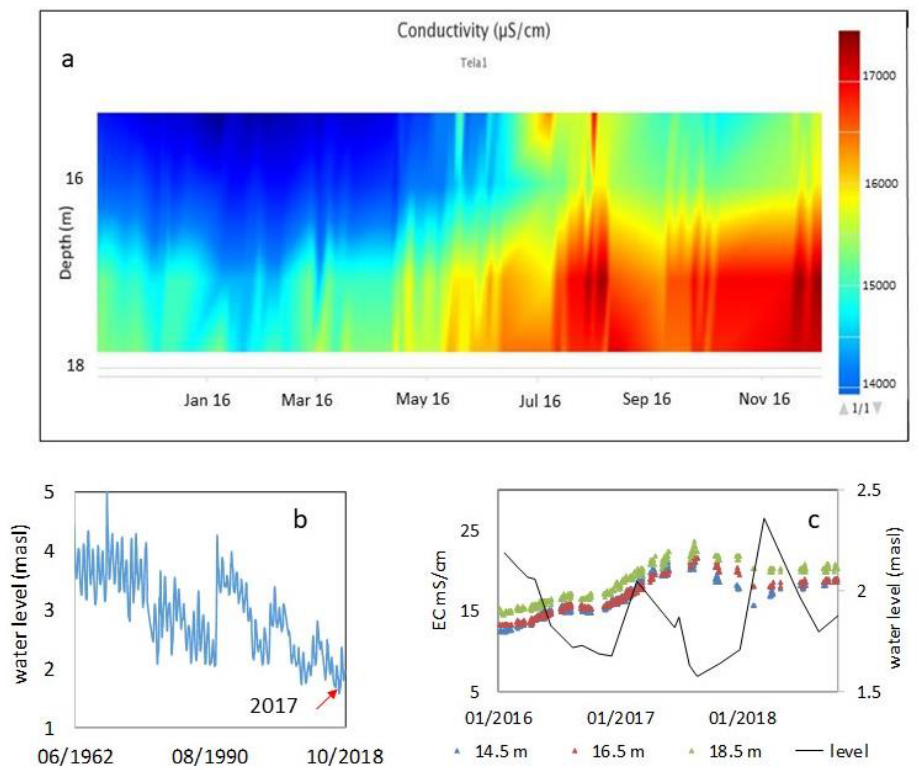
Figure 8. SMD results ( a ) indicating seawater intrusion between January and December 2016. ( b ) The groundwater level in well Hof Carmel 9, which represents the Yarkon Taninim groundwater level in this area. ( c ) is the SMD results showing the EC conductivities at depths 14.5, 16.5 and 18.5 m during January 2016 and August 2018, and water levels in the Hof Carmel 9 well.